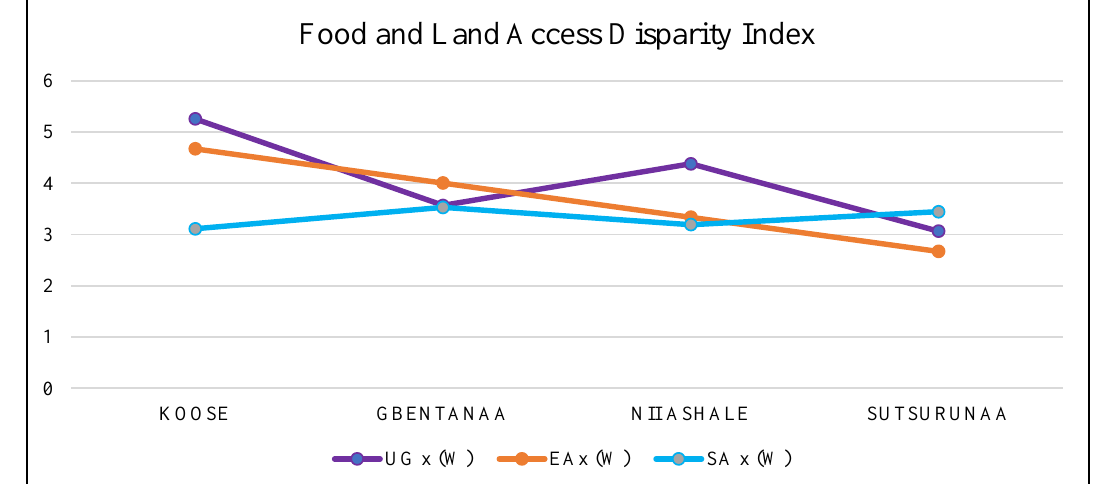
Figure 10. Food and land access disorder index in the municipality (source: field survey, 2019).